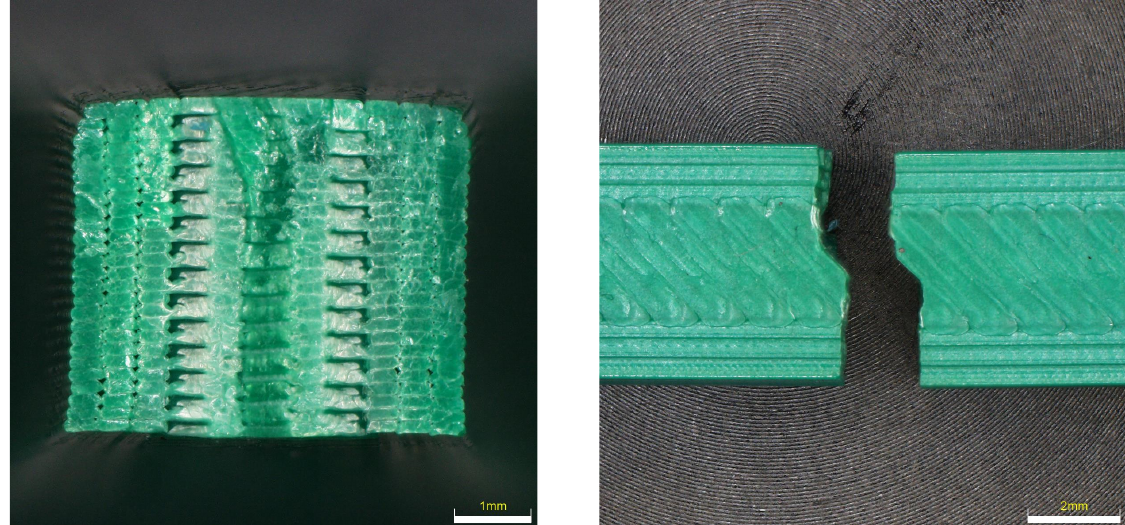
Figure 14. Character of fracture after tensile testing for PLA material.